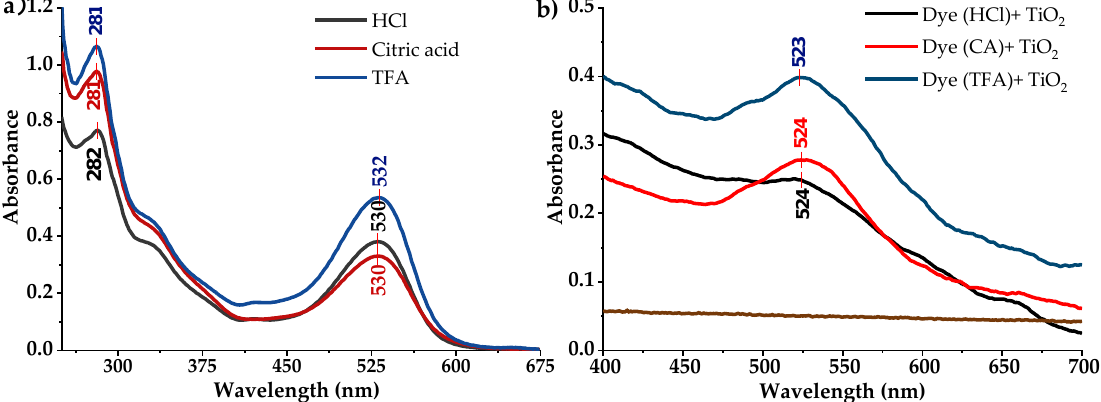
Figure 1. UV-Vis spectra. ( a ) Mortiño pigments diluted in methanol (DF = 100). ( b ) Pigments adsorbed on TiO 2 /FTO (counter electrode).